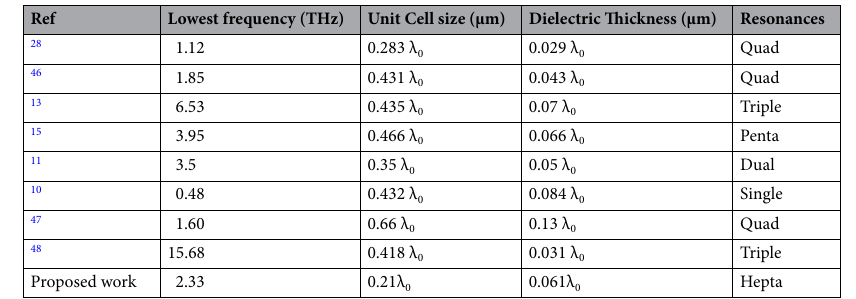
Table 4. Comparison of the previously reported THz MMAs with the proposed MMA.